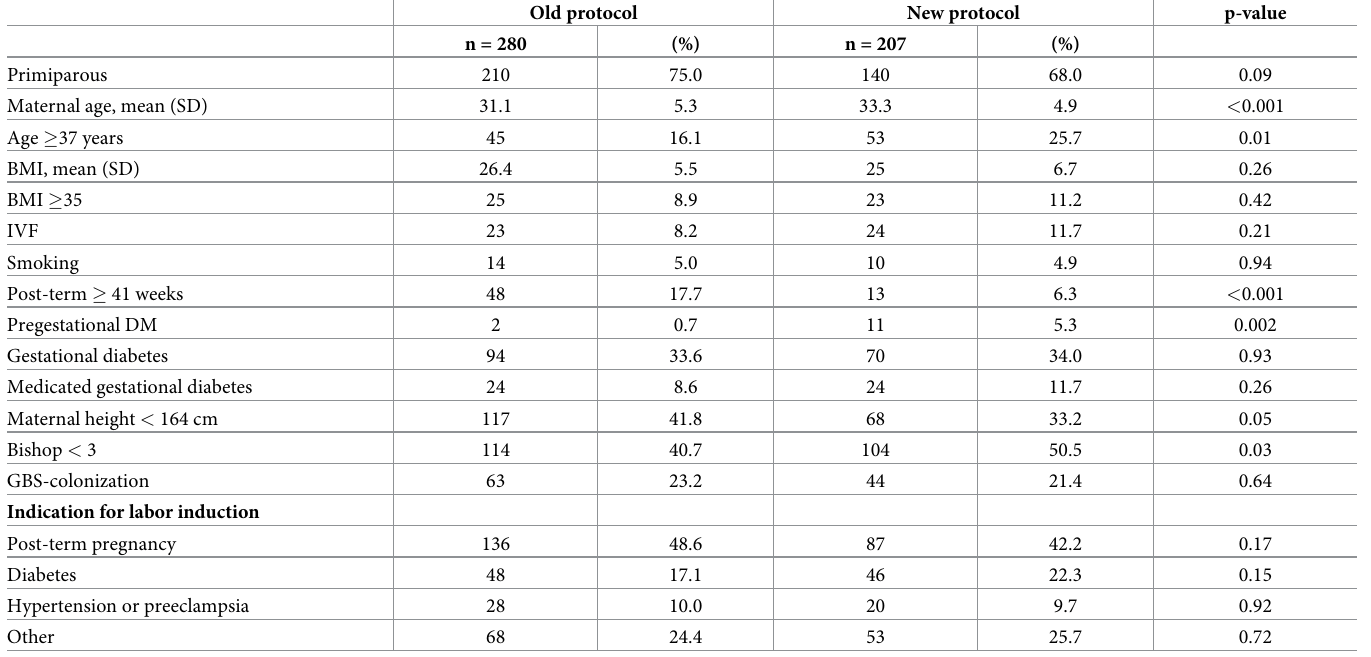
Table 3. Characteristics of the study population.